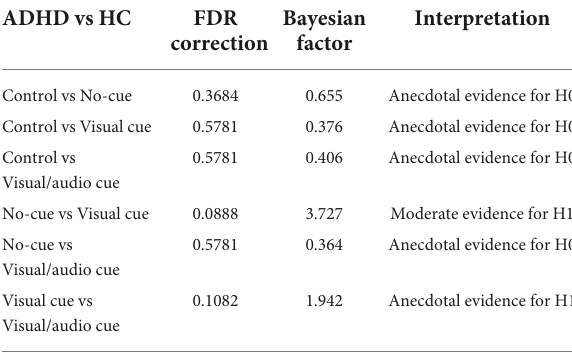
TABLE 4 Post-hoc analysis and Bayesian factor computation results for the post-hoc analyses on the group-by-condition interactions of the linear mixed